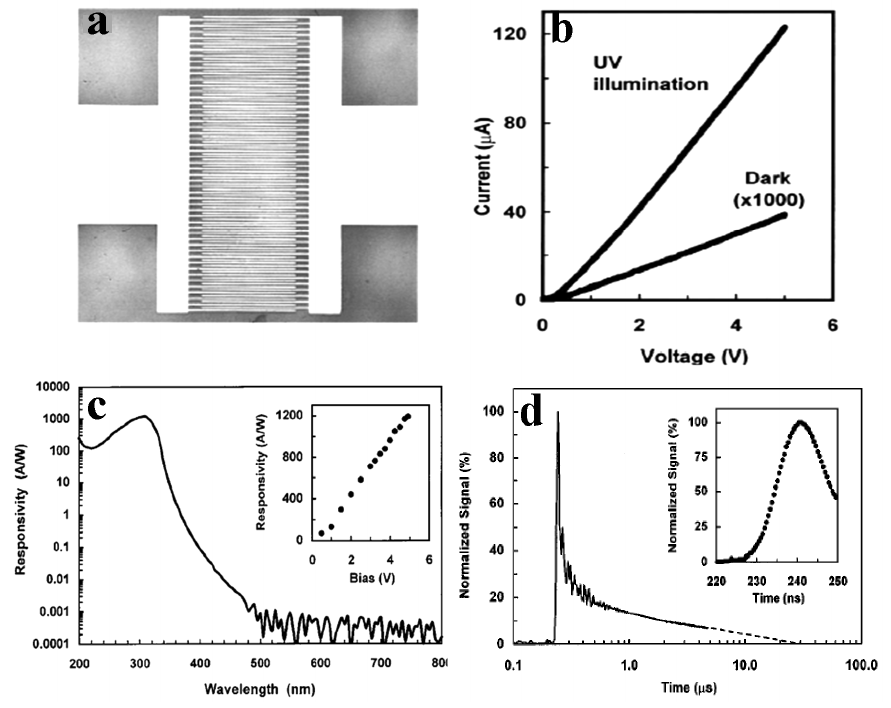
Figure 16. (a) Optical microscope picture of a Mg structure. (b) I - V curves show dark current and photocurrent under 308 nm, 0.1 µ W